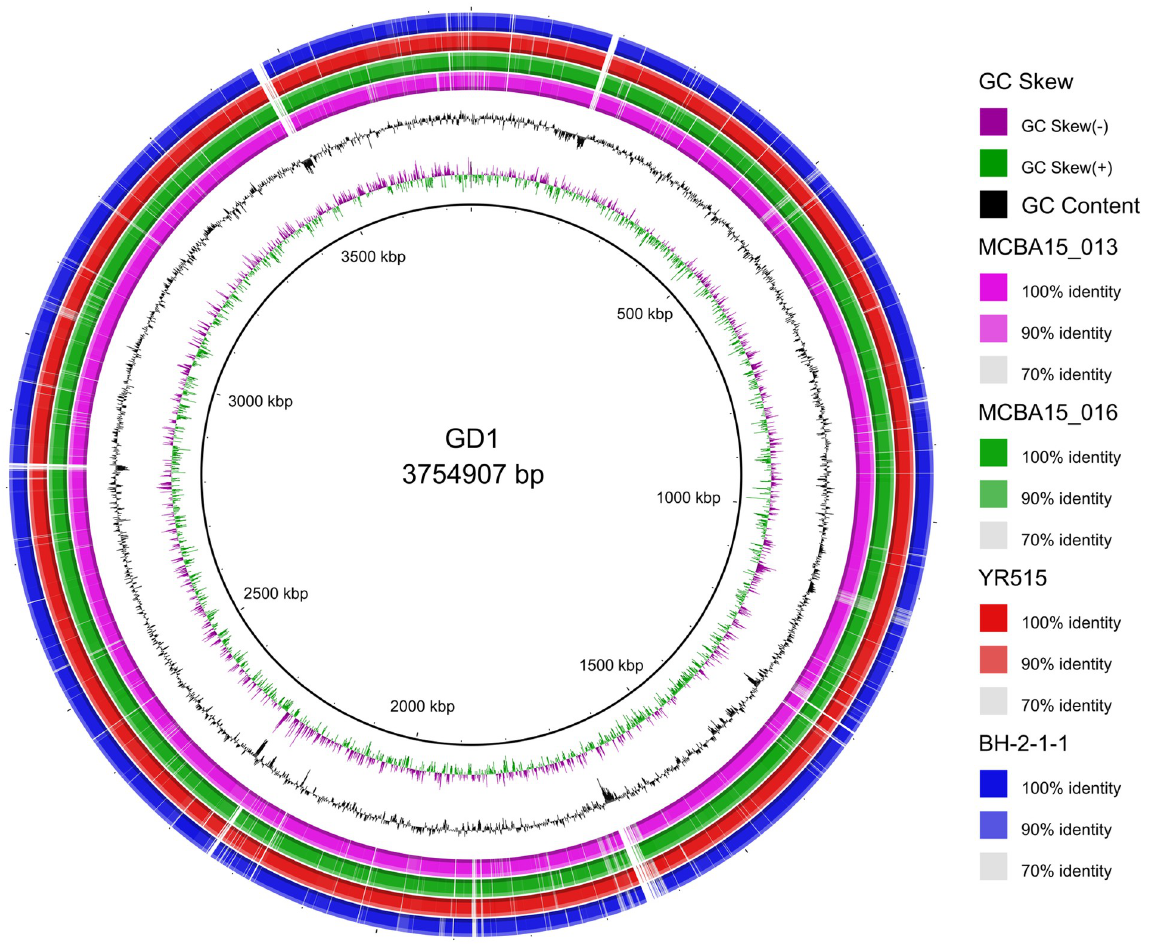
Fig 5. Circular representation of whole-genome sequences of Curtobacterium sp. GD1 and related strains from the same genus. The inner ring portrays the reference GD1 genome with corresponding genetic coordinates. The colored rings (from inner to outer ring) portray: GC skew, GC content and whole-genome sequences of strains MCBA15_013, MCBA15_016, YR515 and BH-2-1-1, as indicated in figure legend.